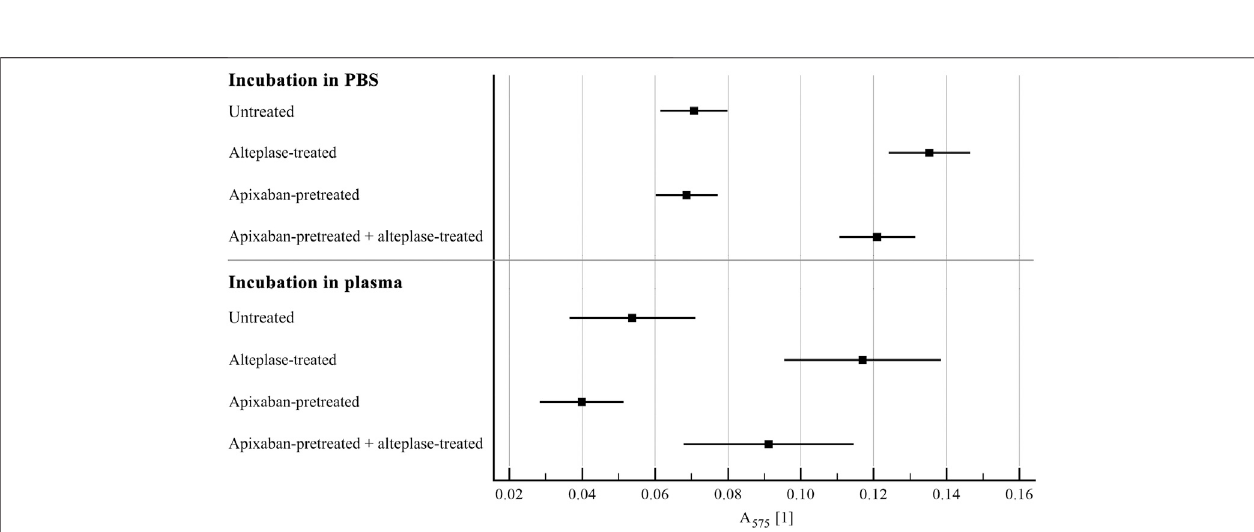
FIGURE 2 | Static model: clot lysis expressed as red blood cell release into incubation media. The forest plot shows mean values (square) and 95% con fi dence interval (whiskers). n (cid:1) 54 – 57 for incubation in PBS and 12 – 15 for incubation in plasma. Results demonstrate that alteplase treatment provided ef fi cient thrombolysis, e.g., documented as greater red blood cell release compared to untreated group in plasma (0.12 ± 0.04 vs. 0.05 ± 0.03, p < 0.01). For clots with and without apixaban, alteplase-induced lysis did not differ, e.g., in plasma red blood cell release was 0.09 ± 0.04 vs. 0.12 ± 0.04, p (cid:1) 0.18. See Supplementary Table S2 for more